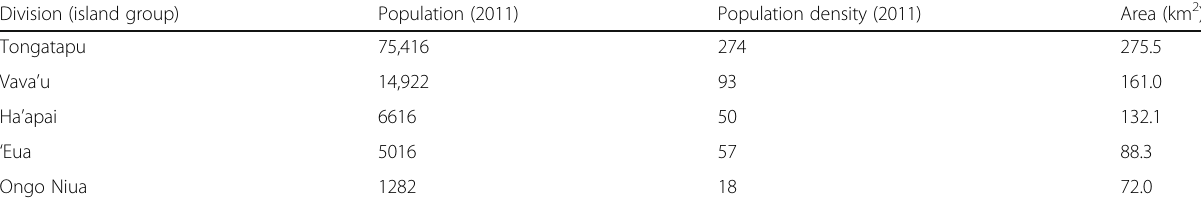
Table 1 Enumerated population and area of different divisions of Tonga Division (island